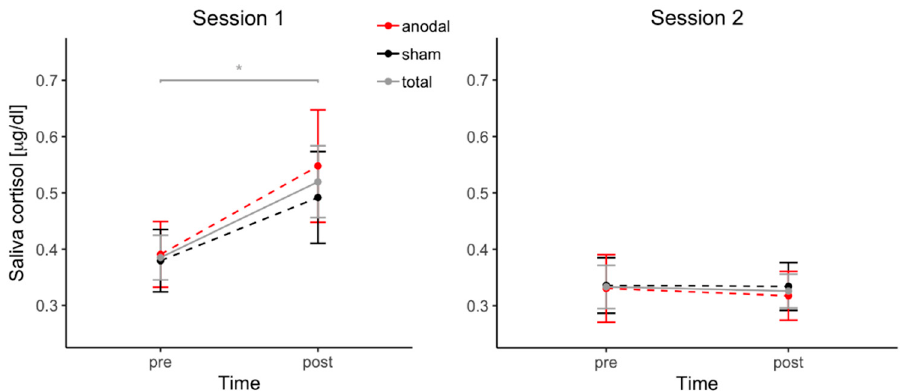
Figure 4. Cortisol concentration changes during each session with regard to stimulation condition. Saliva cortisol levels are shown separately for each session in pre- and post-task condition. As the order of received stimulation (‘anodal/sham’ or ‘sham/anodal’) was a between-subject factor, participants receiving anodal stimulation during the first session ( n = 21) received sham stimulation during their second session, and vice versa ( n = 21). Error bars depict standard errors of the mean; asterisk marks p < 0.05.